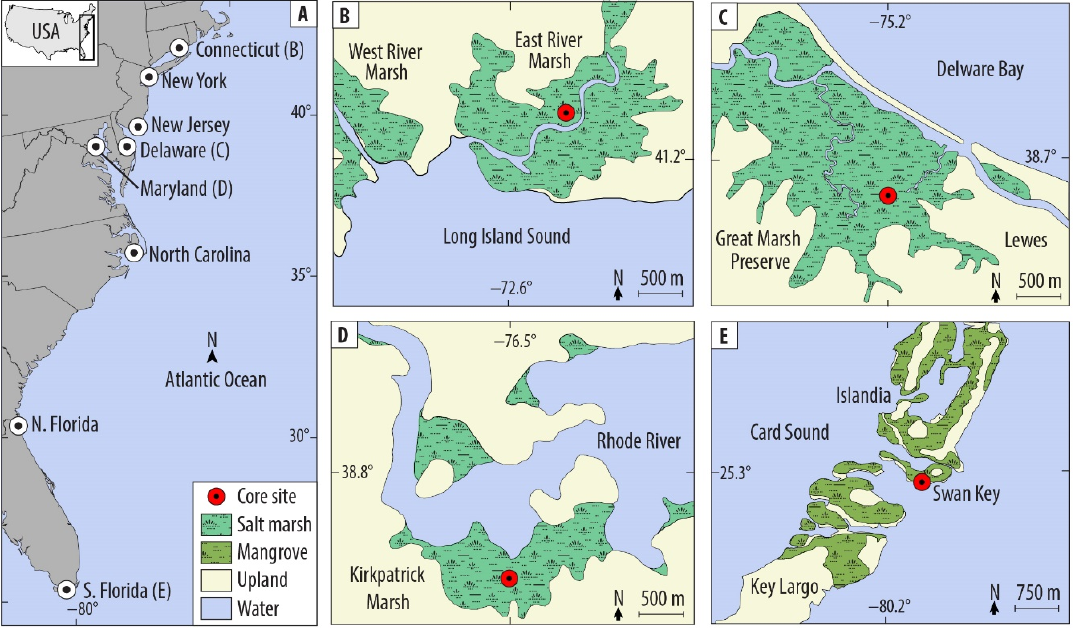
Figure 2. Map of U.S. Atlantic Coast ( A ) showing the relative location of eight published and unpublished study sites, as well as individual site maps for Connecticut ( B ), Delaware ( C ), Maryland ( D ), and Southern Florida ( E ). Maps of other sites can be found in the original publications.